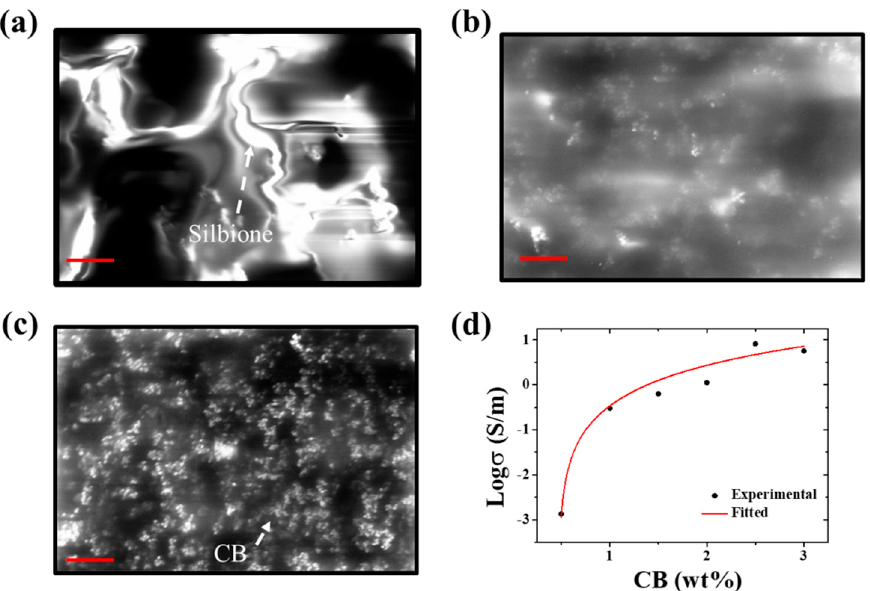
Figure 4. The effect of the CB content on the electrical resistivity of the ternary conductive nanocomposite. SEM image of the ternary conductive nanocomposite containing 0.5wt% CB ( a ), 2wt% CB ( b ) and 3wt% CB ( c ), the scar bar is 8 μ m. ( d ) Log of conductivity as a function of CB content.